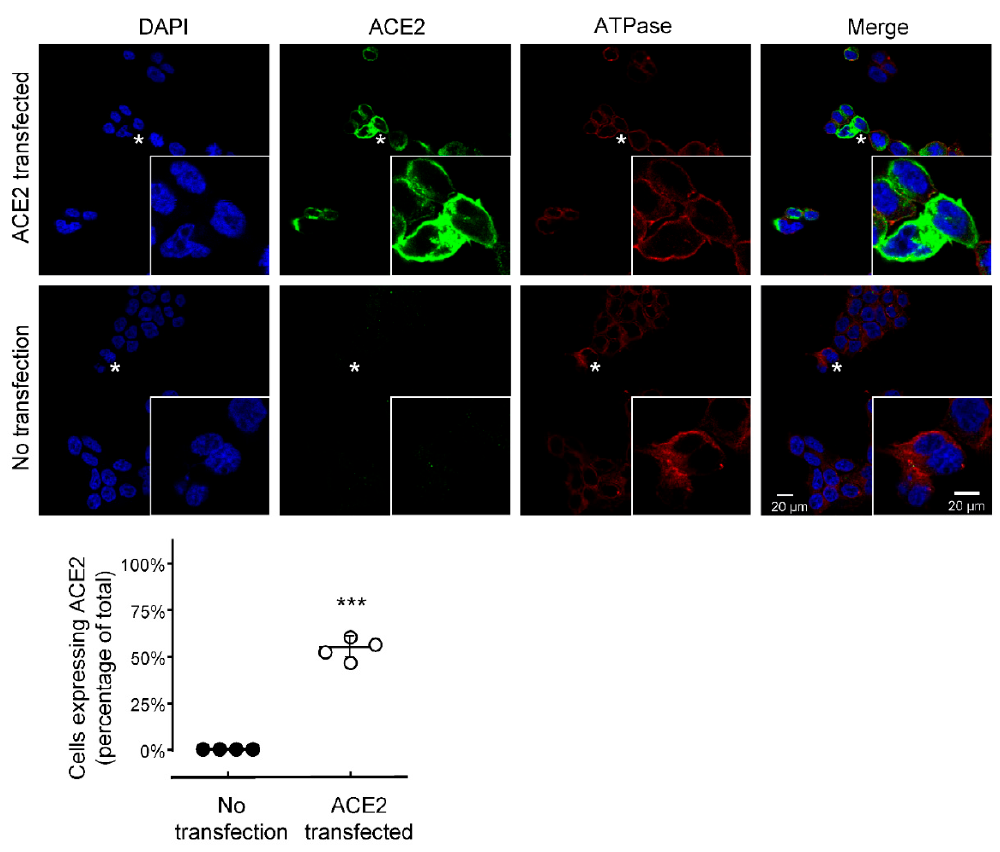
Figure 3. Over expression of ACE2 in HEK293T cells. Cultured HEK293T cells were transfected with cDNA encoding ACE2 for 48 h before being immunolabeled with an anti-ACE2 antibody (in green). The cell nucleus was labelled with DAPI (in blue), while the cytosol and plasma membrane were stained via the expression of ATPase (in red). The cells were visualized, and the images were acquired with a Leica SP8 laser scanning confocal microscope. In each panel, the region indicated by the asterisk is shown in a higher magnification in the inset panel. When the data were quantified, the results showed that >50% of the HEK293T cells had successfully been transfected with ACE2 cDNA. The data represent the mean ± SD; n = 4. The statistical differences were detected utilizing the two-sample t -test, *** p < 0.001.